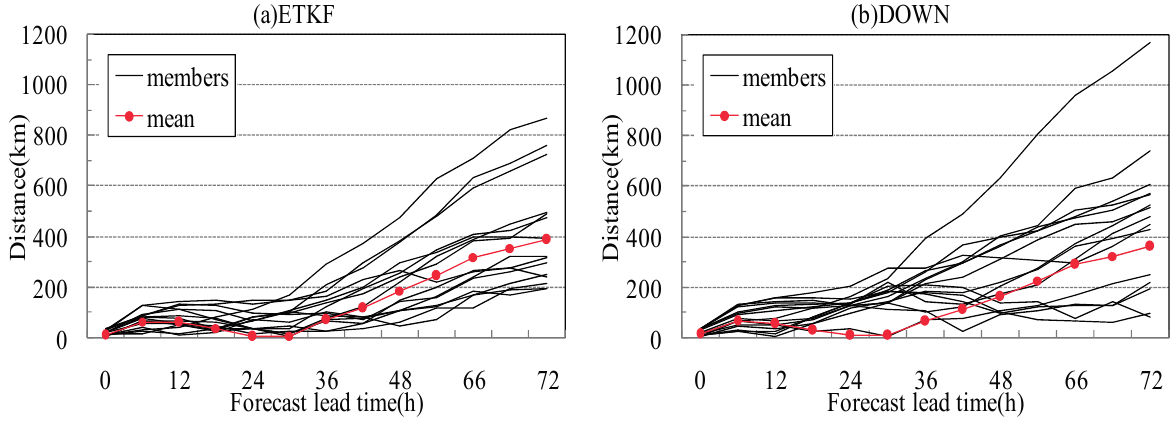
Figure 11. Distance of forecasted tracks and the observational track of Haikui (1211) as a function of forecast lead time, for ( a ) ensemble members and ensemble mean of ETKF and ( b ) ensemble members and ensemble mean of DOWN,